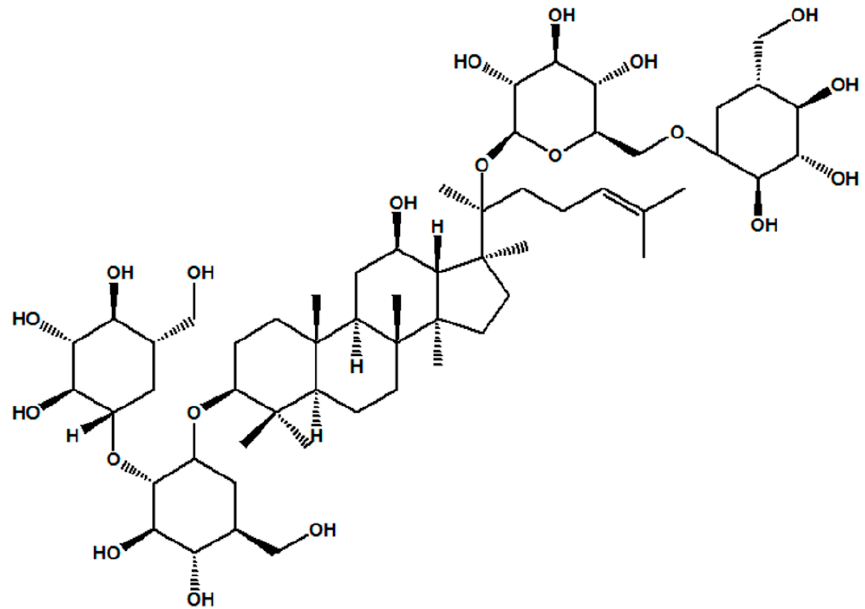
Figure 1. Molecular structure of ginsenoside Rb1.